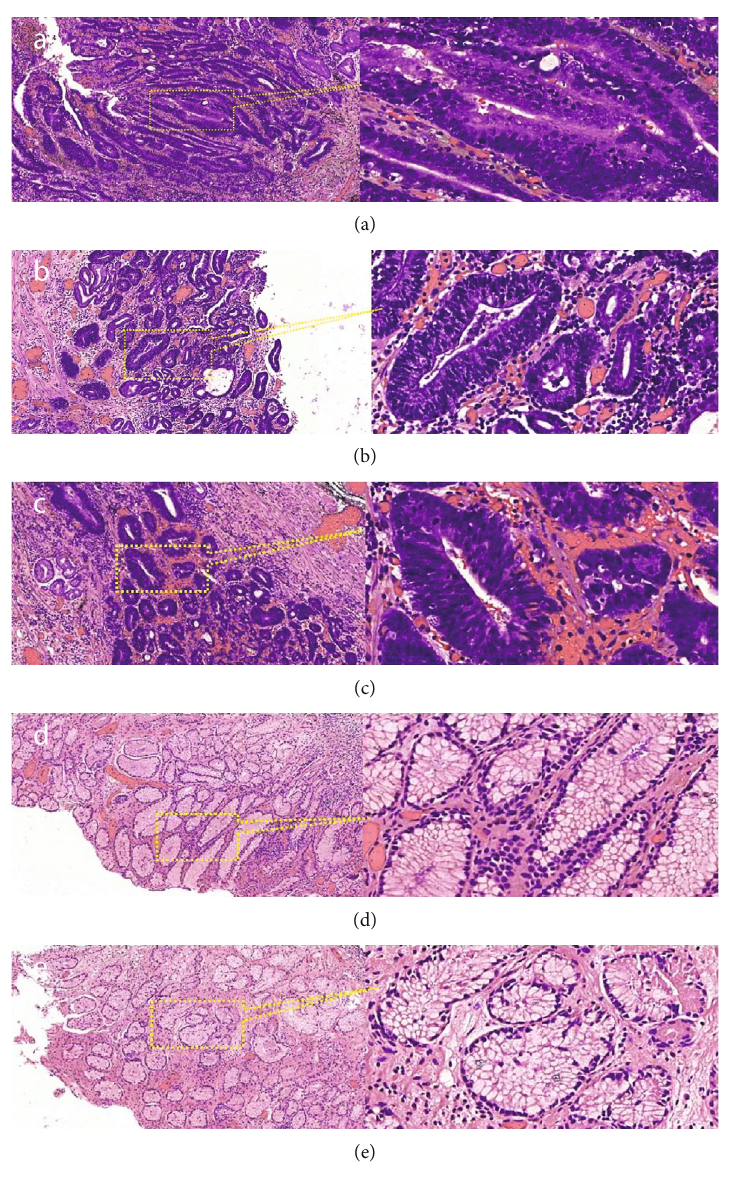
Figure 4: Histopathological results for di ff erent measured sites in ESD specimens: (a – c) measured sites in adenocarcinoma tissue; (d, e) measured sites in nonlesional